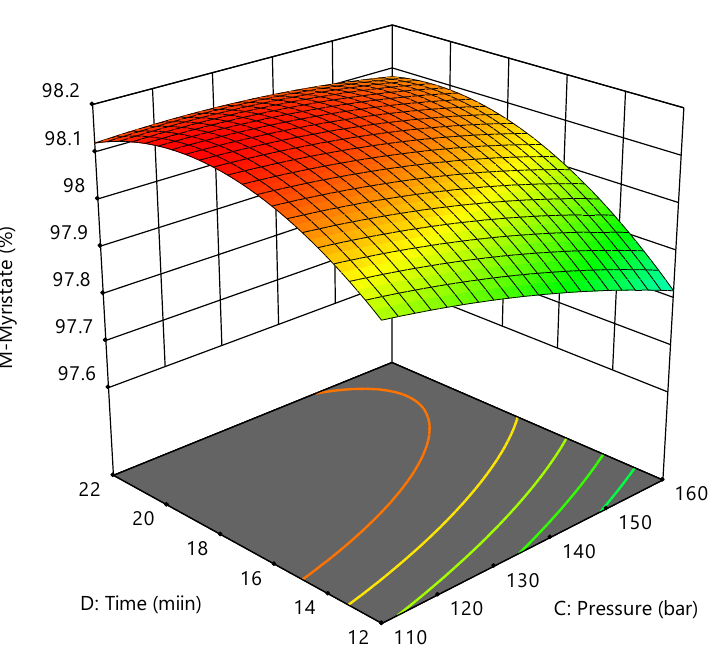
Figure A12. Response surface and contour plot for the effect of reaction pressure and time on the yield of methyl-myristate.